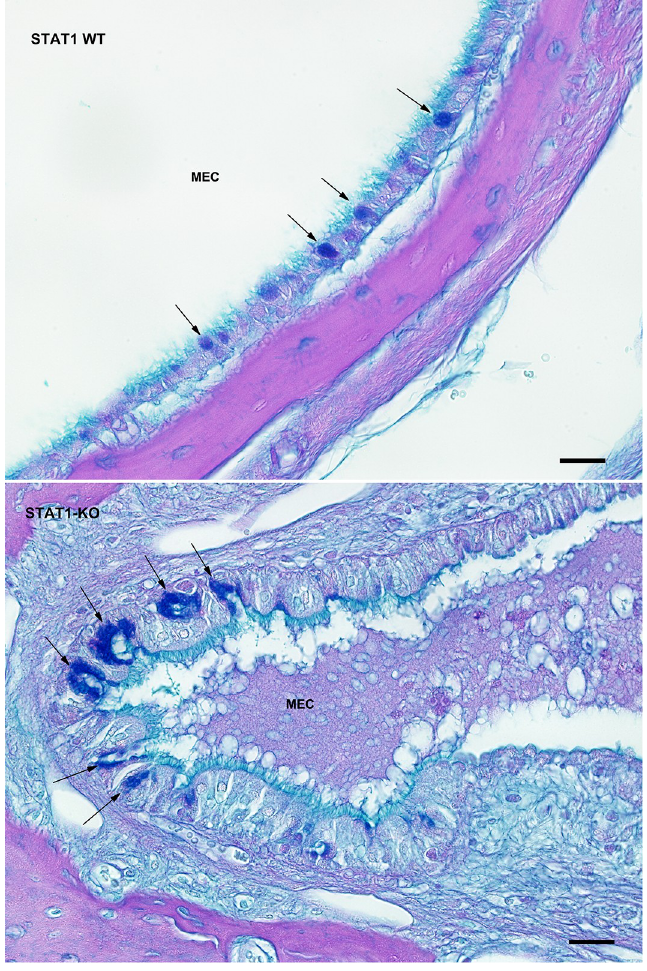
Fig 4. Cluster of goblet cells were found in STAT1-KO mice with otitis media. Middle ear sections from wild type and STAT1-KO mice were stained for goblet cells by mucin staining using AB-PAS method. More AB-PAS-positive cells were found in the mucosal layer of the MEC of STAT1-KO mice than in wild type (WT), as indicated by arrows. Scale bars 30 μ m.